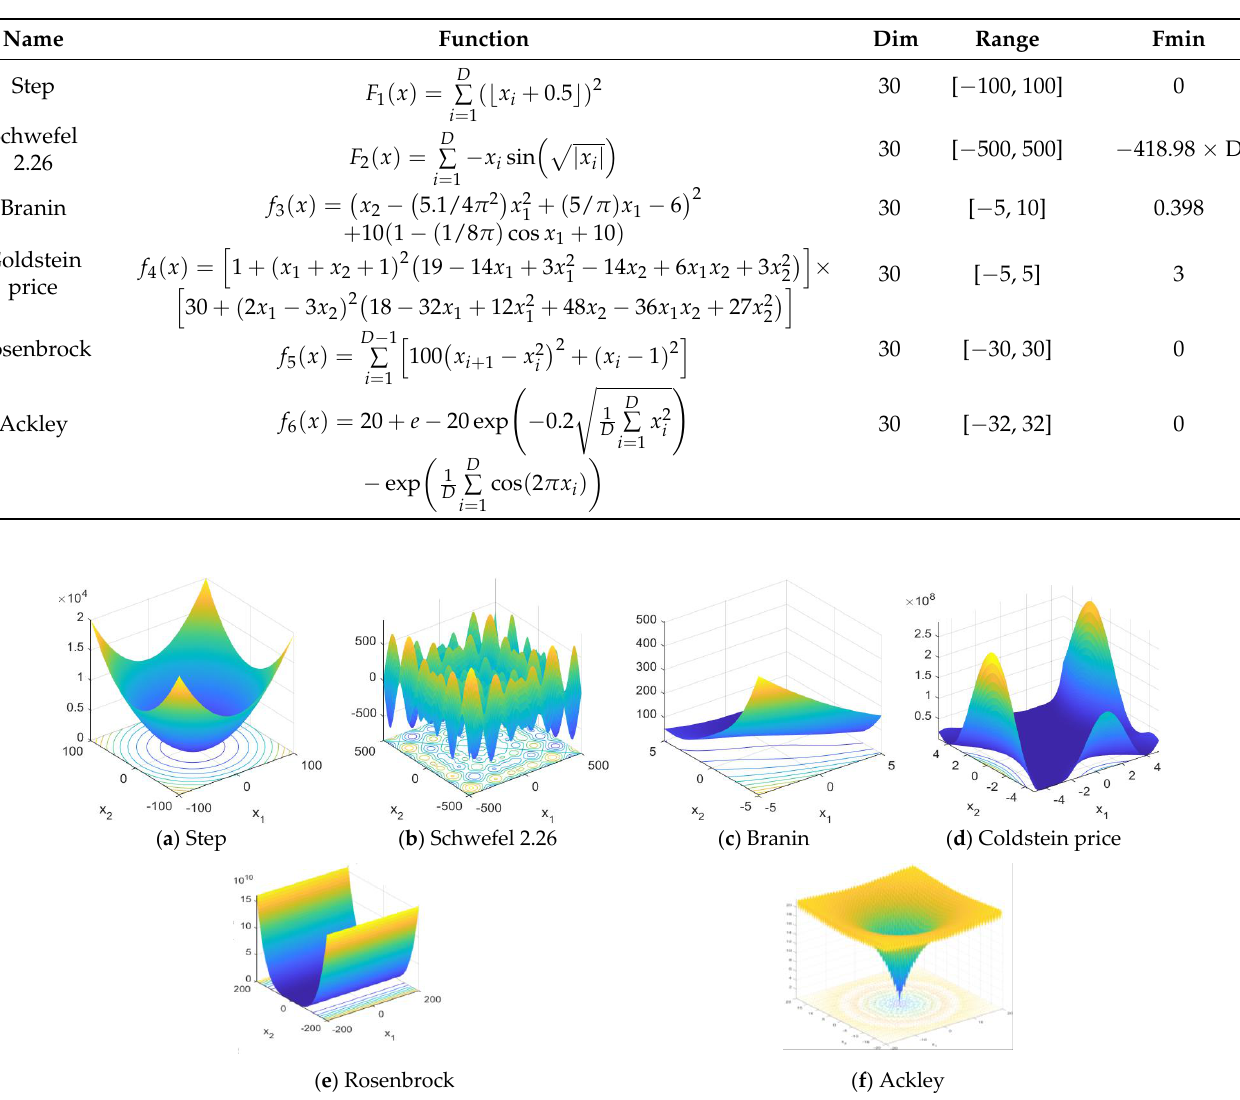
Figure 8. Three-dimensional visualization of two-dimensional benchmark functions. Table 6. Experimental results in 30 dimensions.